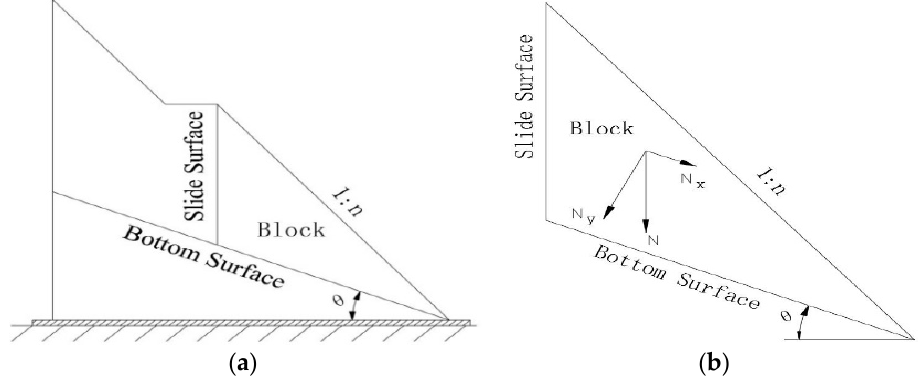
Figure 1. Schematic diagram of rock slope in natural state and load analysis: ( a ) slope in natural state; ( b ) load analysis.